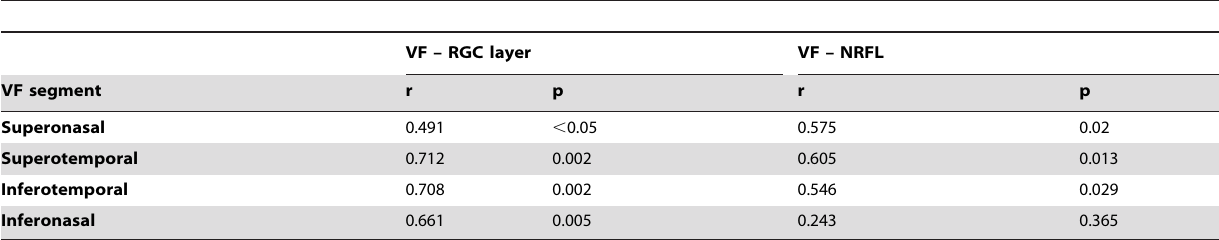
Table 2. Correlation coefficients between the GCL and RNFL thickness and the VF deviation in corresponding quadrants.